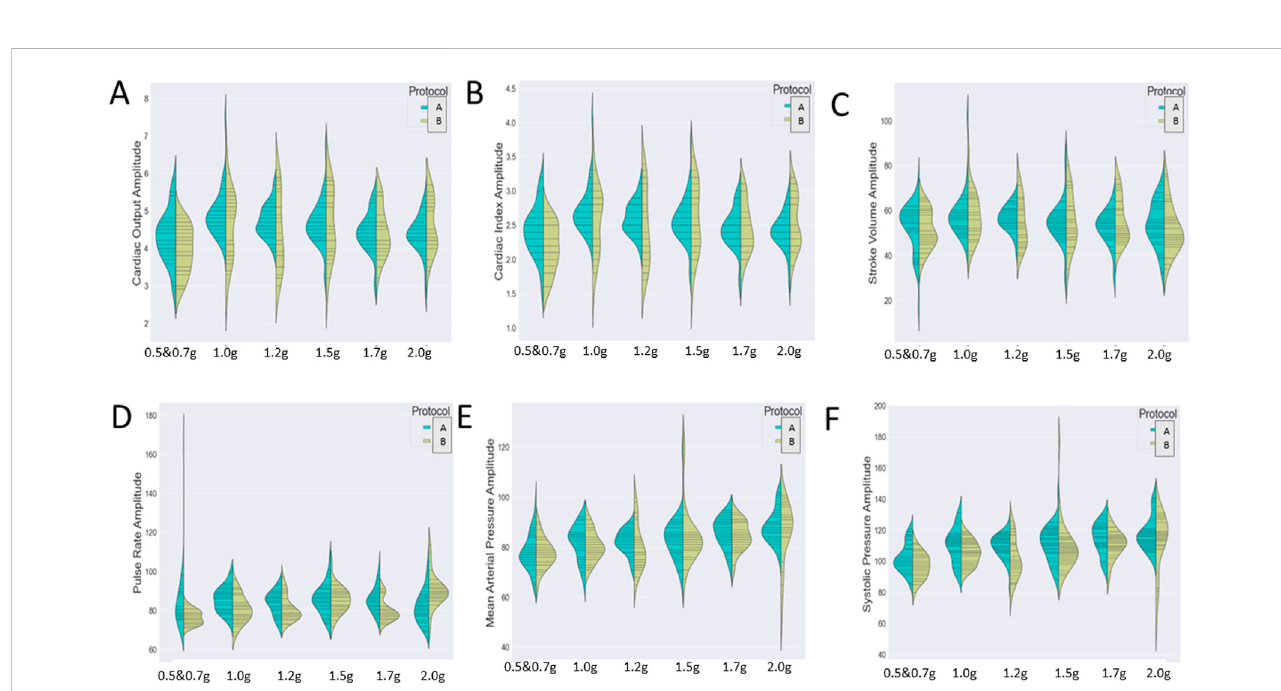
FIGURE 7 Visualization of six cardiac markers [ (A) cardiac output, (B) cardiac index, (C) stroke volume, (D) pulse rate, (E) mean arterial pressure, and (F) systolic pressure] comparing the effect of protocols A (1) and B (2) either combined with exercise or not. The number of measurements for SAHC alone (both protocols) was 30 measurements (three measurements per week), and that for combined with exercise (both protocols) was also 30 measurements. For the grip strength and balance, the measurements were taken upon arrival after 5 min standing for the “ pre ” values and 5 min after the end of centrifugation for the “ post ” values. The EEG data were taken before entering the rehabilitation with SAHC and after each protocol. The fi gure visualizes the distribution of each marker ’ s instance for AG training protocol A alone and combined with exercise (green color) and protocol B alone and combined with exercise (yellow color). Elongated violin plot edges represent the existence of outliners, while their width is proportional to the existence of the